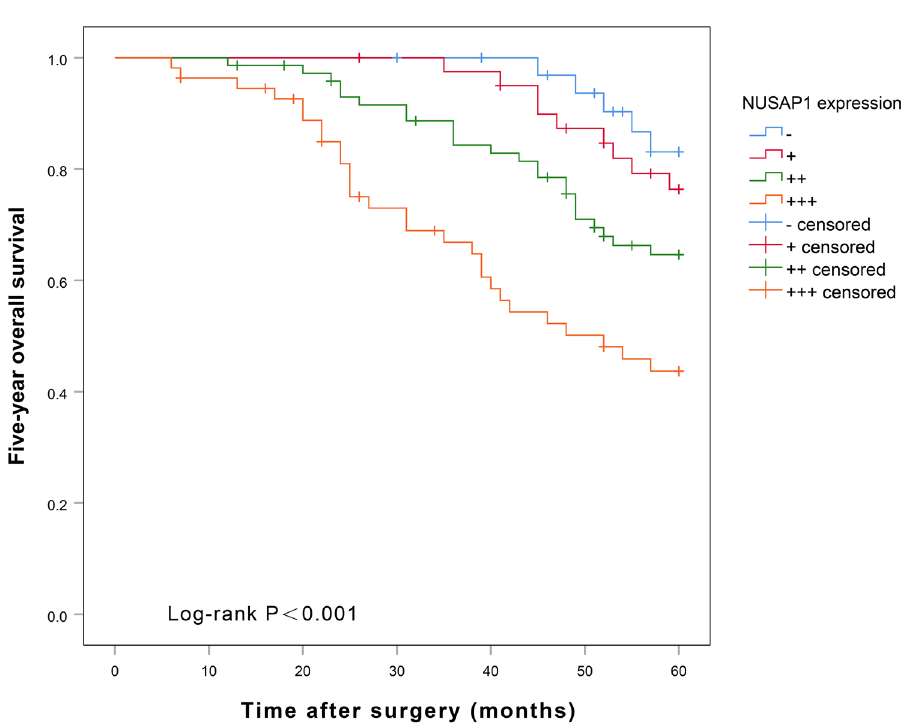
Figure 6. NUSAP1 expression levels and 5-year overall survival curves for BUC patients after radical